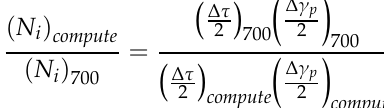
Table 2. Computation results of shear stress amplitude ( ∆ τ